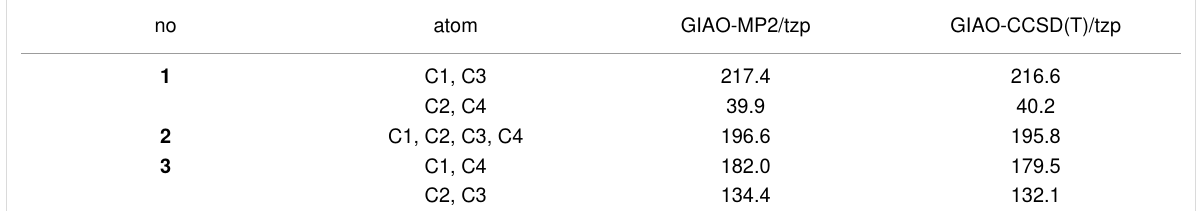
Table 1: GIAO calculated a 13 C NMR chemical shifts using CCSD(T)/cc-pVTZ